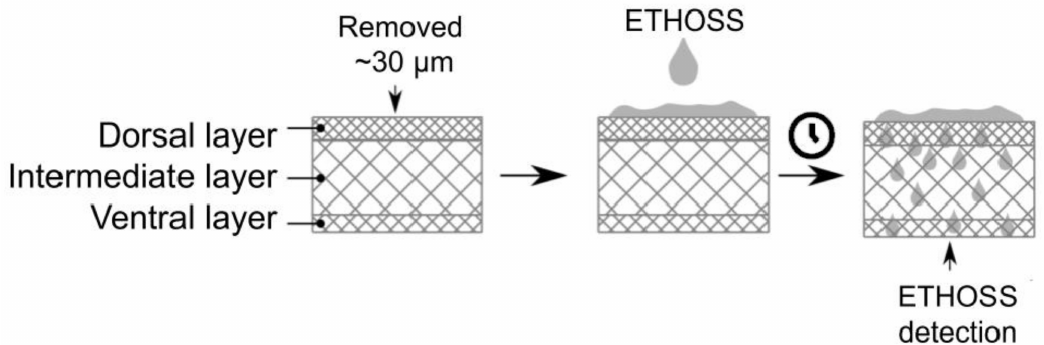
Figure 3. Scheme adapted from Veiga et al. [15], illustrating the anatomy of the nail with its three regions: dorsal (external), intermediate, and ventral (internal). The application of ETHOSS on the dorsal side and evaluation of its permeation to the ventral side. It was also applied on the ventral surface, following a similar scheme not represented